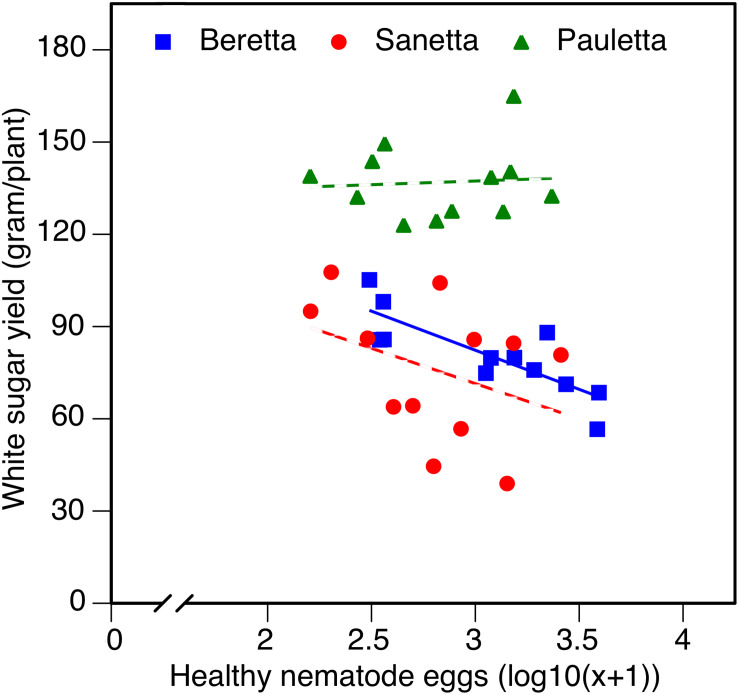
White sugar yield of sugar beet in relation to healthy nematode eggs at planting in Heterodera schachtii Schach 0-infested soil in 2010–2012. Data are averaged across treatment. Solid line: Beretta f(x) = –25.4395 x + 158.6060, R2 = 0.64; P < 0.01; hatched line: trendlines for Sanetta and Pauletta.